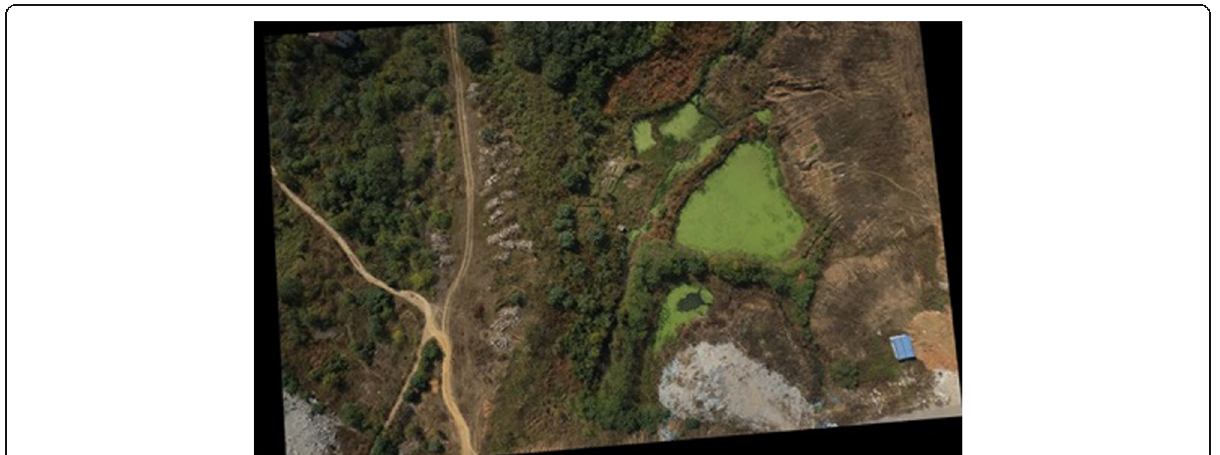
Fig. 37 Result graph of the right image after perspective